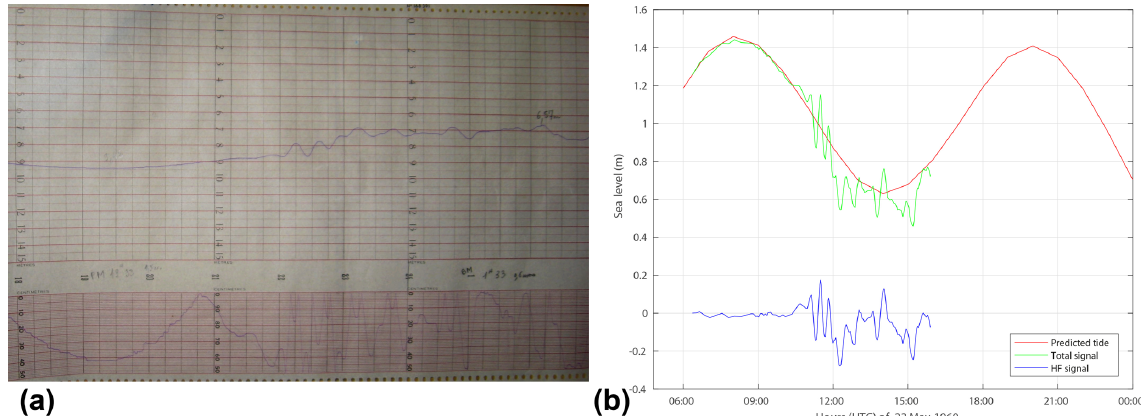
Figure 11. Tide gauge record of the 22 May 1960 Chile tsunami in Nouméa (Chaleix station): original record (a) and digitized signal (b) , total (in green) and detided (in blue).